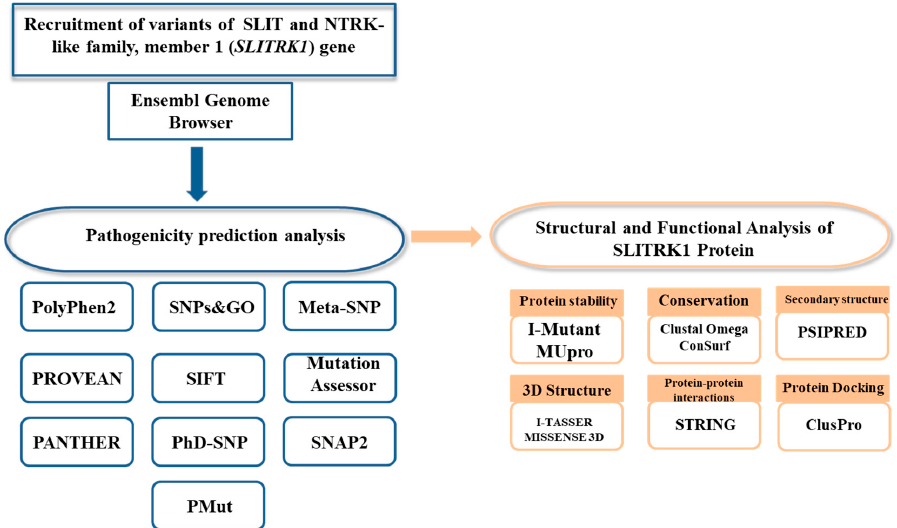
Figure 2. Flowchart of the methodology.